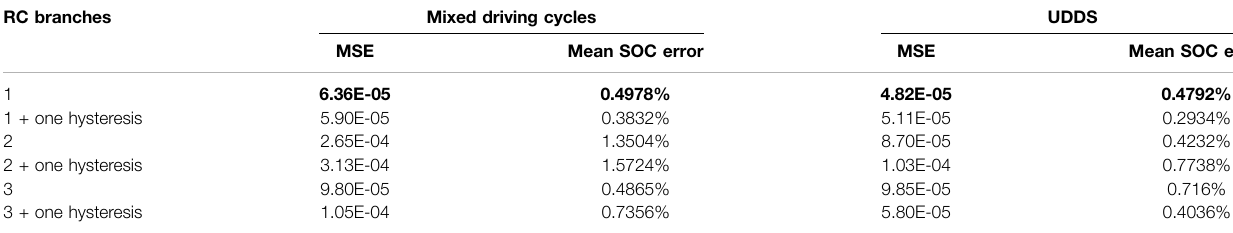
TABLE 4 | AUKF with moving windows M = 150.